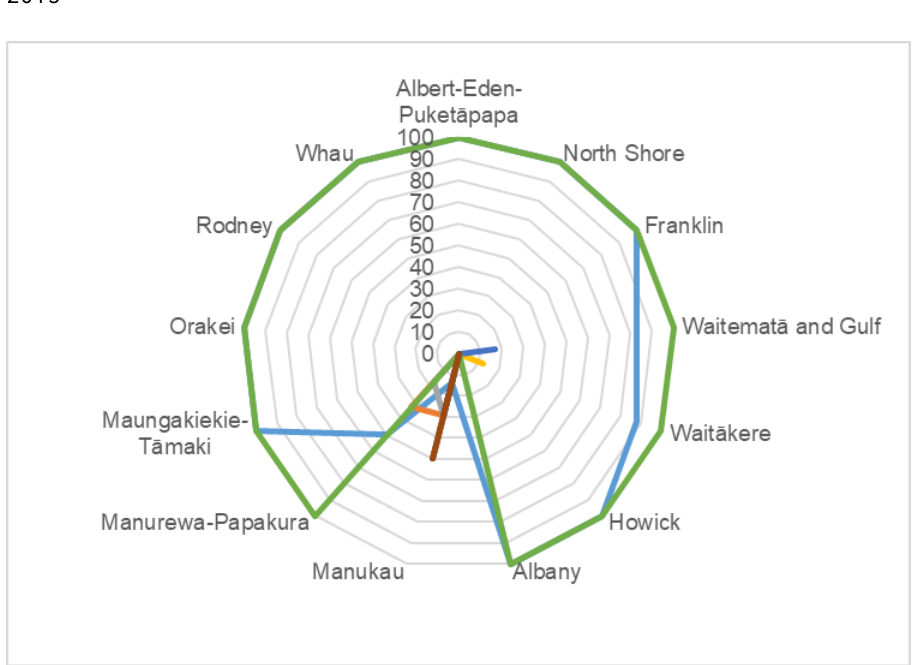
Figure 5: Candidate and elected member ethnicity in Auckland Council wards, 2013 to 2019 Key